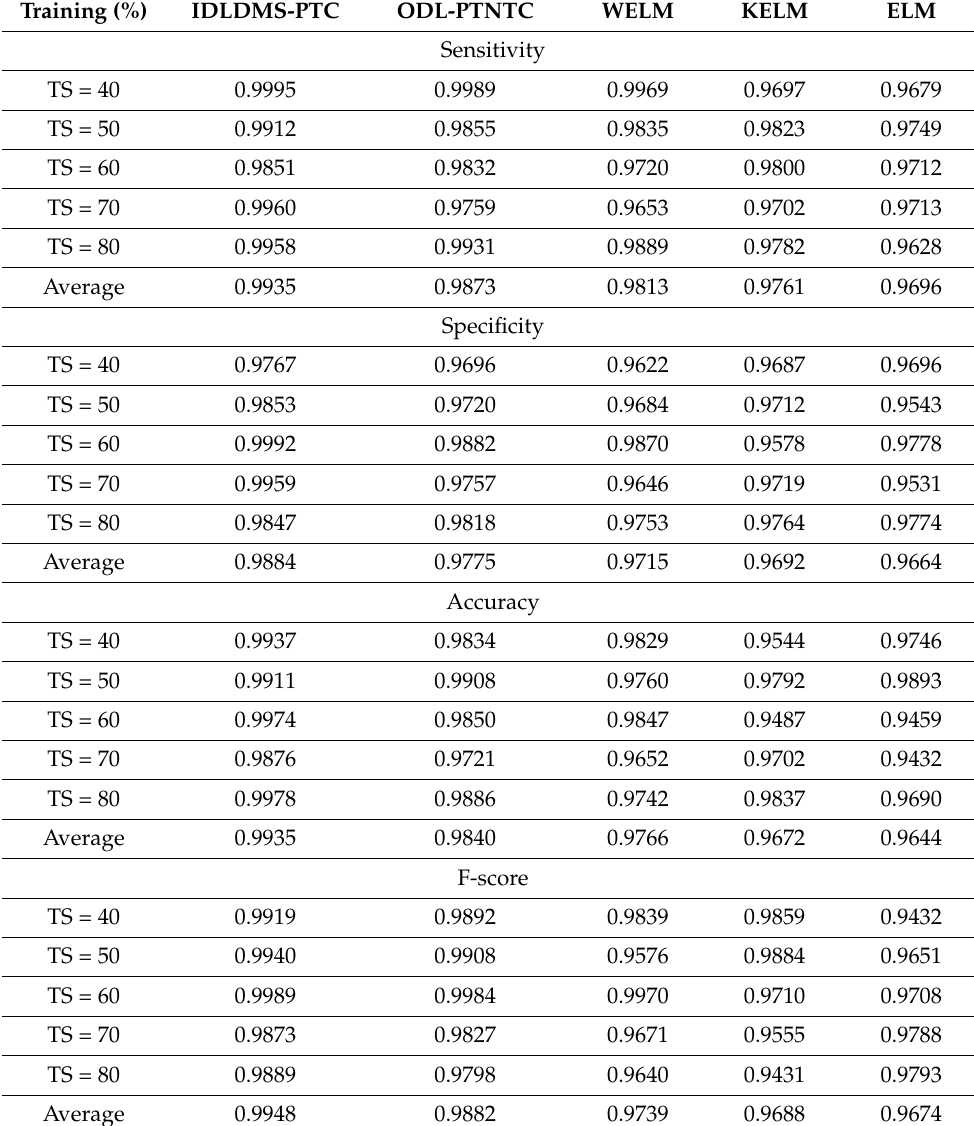
Table 1. Results analysis of IDLDMS-PTC technique under different sizes of training set with existing